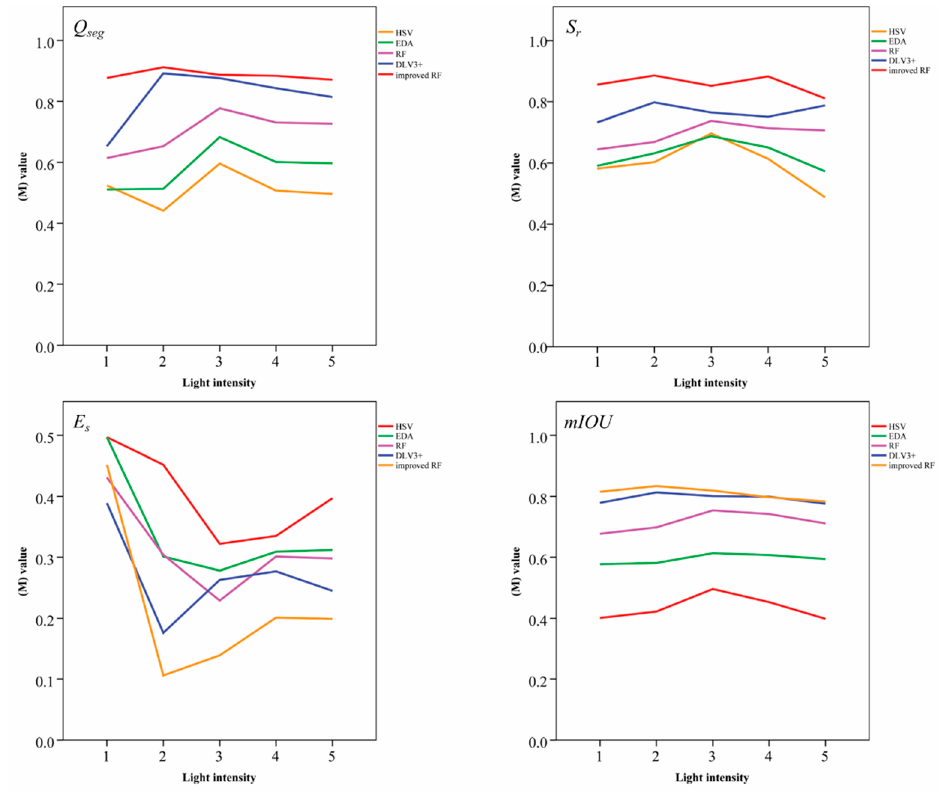
Figure 5. Results of image segmentation models for di ff erent illumination conditions. The color lines in each box represent how the indexes vary as illumination conditions when using di ff erent methods. Panels 1–5 show the results for light intensities ranging from dark to bright.